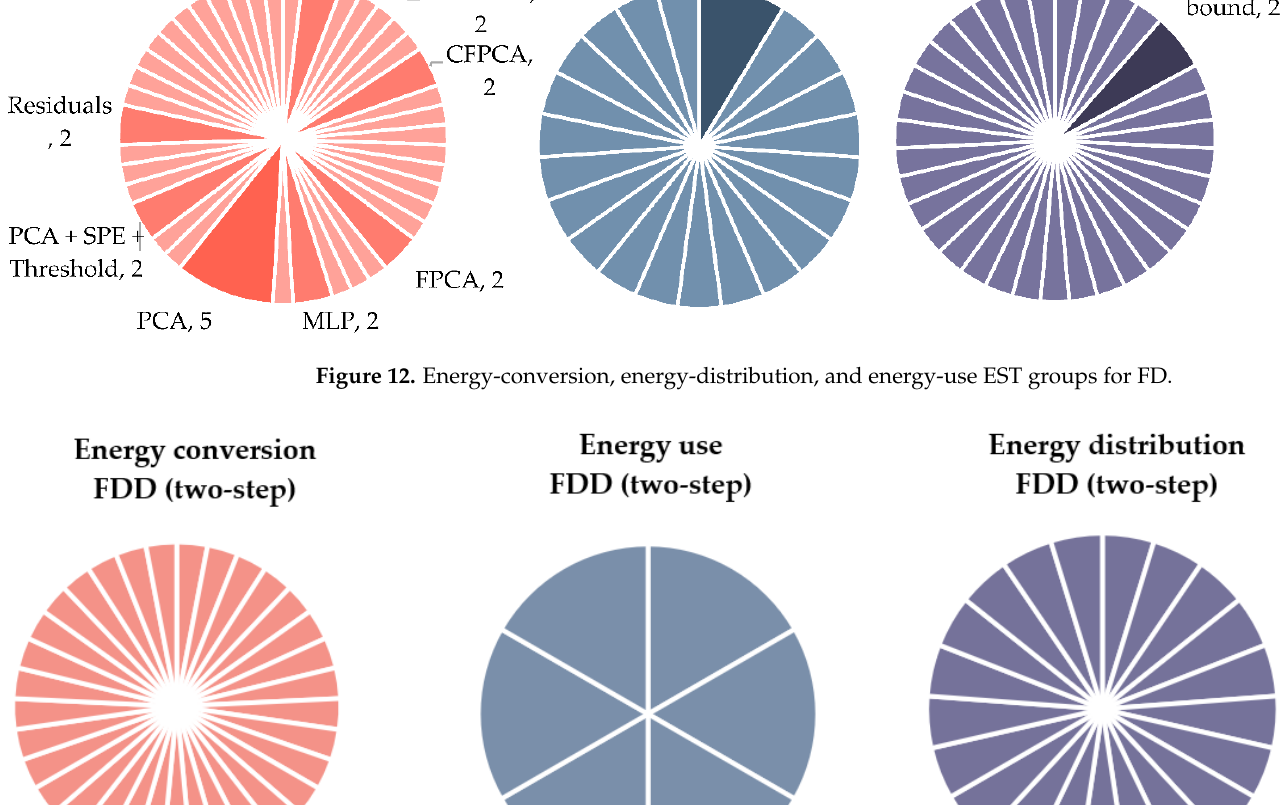
Figure 14. Energy-conversion, energy-distribution, and energy-use EST groups for one-step FDD. Figure 12 shows that a vast amount of algorithms were applied in the different re- viewed articles. However, a few of them stood out. For energy-conversion systems, these were PCA and variations of PCA. Further, residuals, multilayer perceptron (MLP), and ANN + residual algorithms were applied twice. Moreover, for energy distribution, the Chernoff bound, and for energy use, ANN were both found to be applied two times. For two-step FDD, which can be seen in Figure 13, all algorithms were found to be only used once. As two-step FDD requires two various algorithms, one for fault detection and one for diagnosis, this was considered a natural finding. It could, however, also imply that the field is still in the process of maturing through testing different combinations of algorithms.